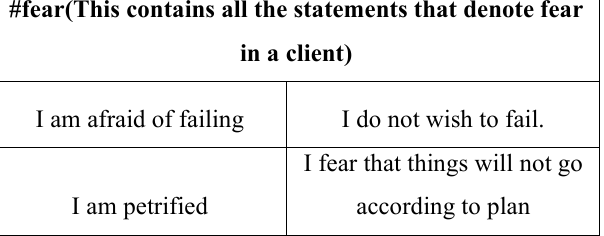
Table 6. Intent #fear Details and case examples configured